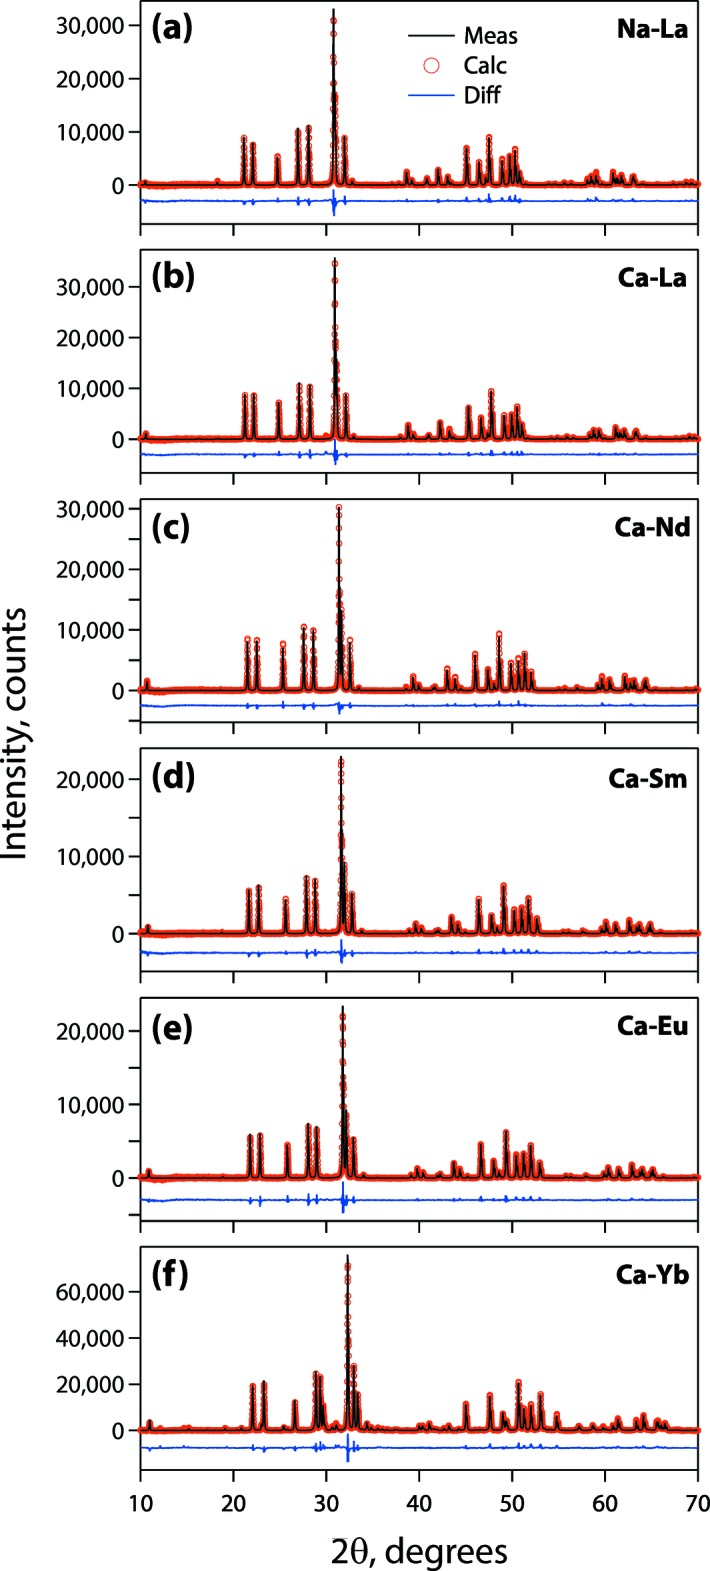
Measured, calculated, and difference XRD profiles of (a) NaLa9(SiO4)6O2, (b) Ca2La8(SiO4)6O2, (c) Ca2Nd8(SiO4)6O2, (d) Ca2Sm8(SiO4)6O2, (e) Ca2Eu8(SiO4)6O2, and (f) Ca2Yb8(SiO4)6O2.